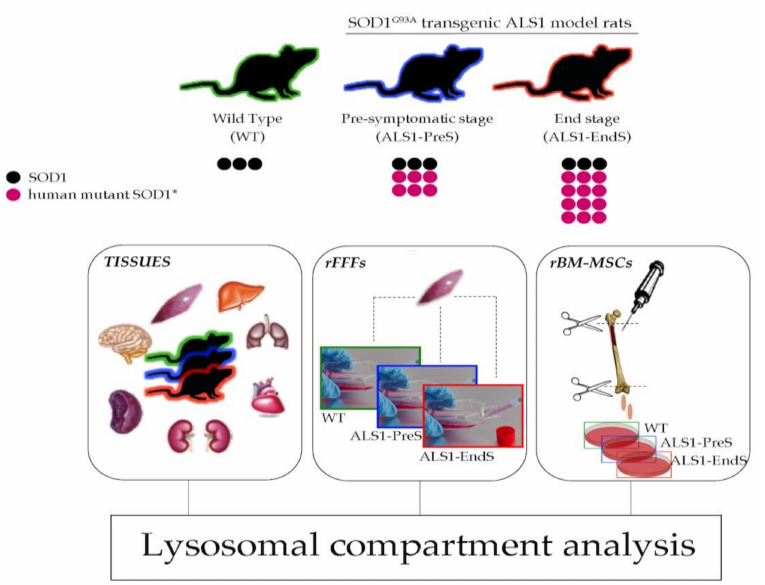
Figure 1. Schematic of the experimental plan for the study of the lysosomal activity in tissues and non-neural cells from transgenic ALS1 rats G93A model. rFFFs: rat Fibroblasts; rBM-MSCs: rat bone marrow-mesenchymal stem